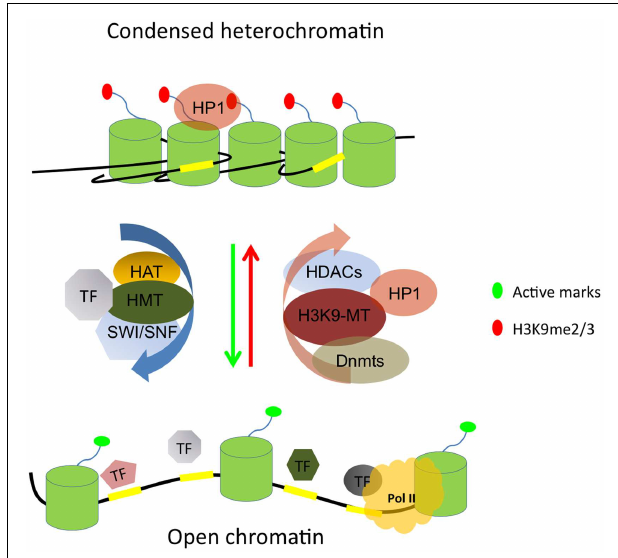
FIGURE 1 | Simplified scheme of condensed heterochromatin and open chromatin features. Heterochromatin is mostly hypo-acetylated, marked by methylated lysine 9 on histone H3 (H3K9me2/3) which forms a binding site for heterochromatin protein 1 (HP1), contains methylated DNA, and results from the action of repressive complexes such as histone deacetylases (HDACs), H3K9 methyltransferases (H3K9-MT), and DNA methyltransferases (Dnmts). Chromatin opening is orchestrated by the concerted action of transcription factors (TFs) and chromatin modifying enzymes such as histone methyltransferases (HMTs), histone acetyl transferases (HATs), and SWI/SNF remodeling complexes. Open chromatin is generally acetylated, harbors active histone marks, and is accessible to the transcription machinery and RNA polymerase II (Pol II).TF binding sites (TFBSs) are indicated by yellow rectangles and the nucleosomes consisting of histone octamers are depicted by green cylinders. For simplicity, only a single histone tail is shown protruding out of each nucleosome and DNA methylation is not